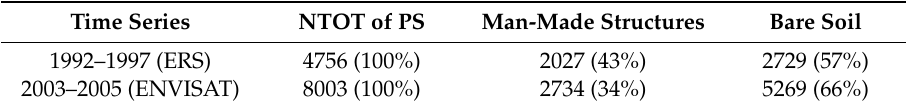
Table 3. Number of Persistent Scatterers (total, on man-made structures and bare